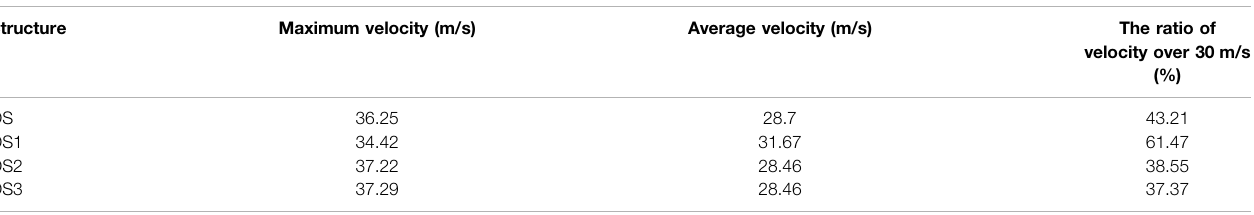
TABLE 2 | The velocity results of outlet section of different structures.